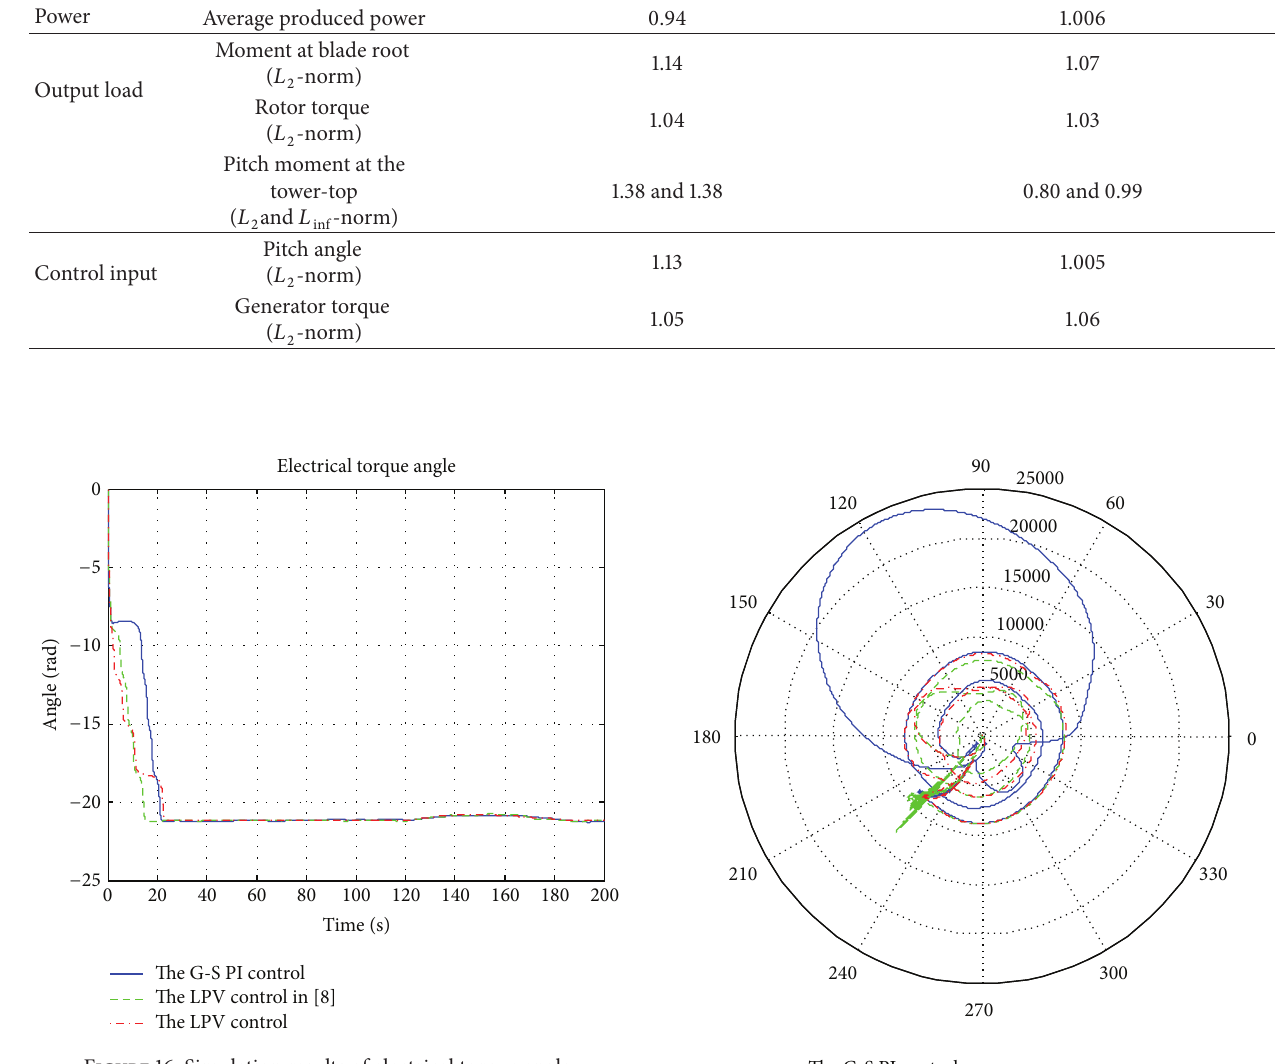
Figure 16: Simulation results of electrical torque angle.